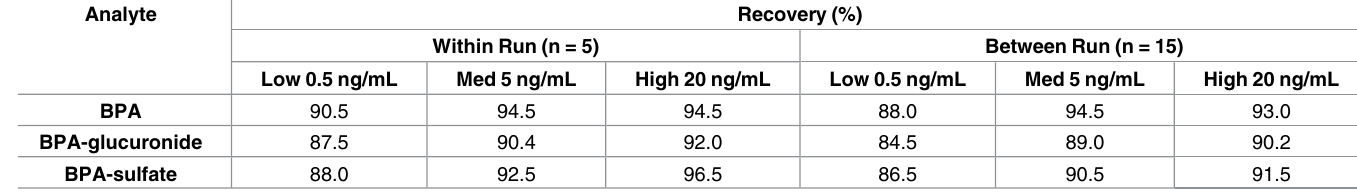
Table 2. Validated method recoveries established for the direct analysis of BPA and its primary metabolic conjugates in amniotic fluid using LC-MS/MS.